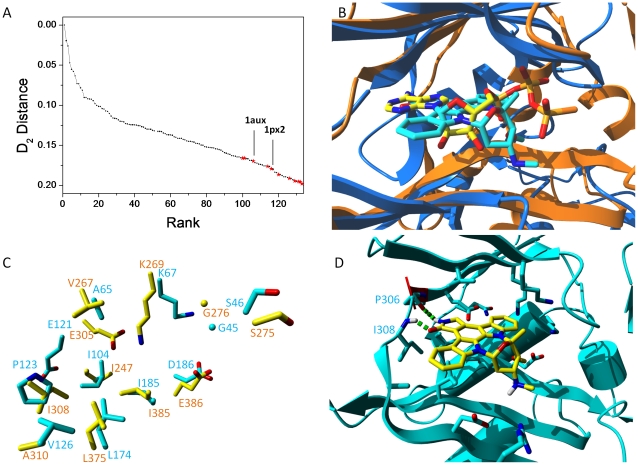
Similarity of the ATP-binding sites of Pim-1 kinase and of synapsin I.
A. SiteAlign [41] virtual screening of 6 415 sc-PDB binding sites to the staurosporine binding site of human Pim-1 kinase (1yhs). Entries exhibiting similar binding site properties (d2 <0.20) are ranked by decreasing d2 distance to the query. ATP-binding sites of protein kinases are displayed by dark circles, other binding sites by red stars. Two ATP-binding sites of synapsin I are labeled by their Protein Data Bank entry name (1aux, 1px2). B. 3-D SiteAlign alignment of human Pim-1 (1yhs, blue ribbons) bound to staurosporine (cyan sticks) and of bovine synapsin I (1aux, orange ribbons) bound to adenosine 5′-diphosphate monothiophosphate (yellow sticks). Nitrogen, oxygen and sulfur atoms of bound ligands are colored in blue, red and orange, respectively. C. 11 matching residues between the ATP-binding sites of Pim-1 (1yhs, cyan sticks) and synapsin I (yellow sticks). Residues are labeled according to the PDB residue numbering at their Cα atom. D. Putative docking pose of staurosporine (yellow sticks) to the bovine synapsin I X-ray structure (1aux, cyan ribbons). Protein-ligand hydrogen bonds are displayed by green dots.